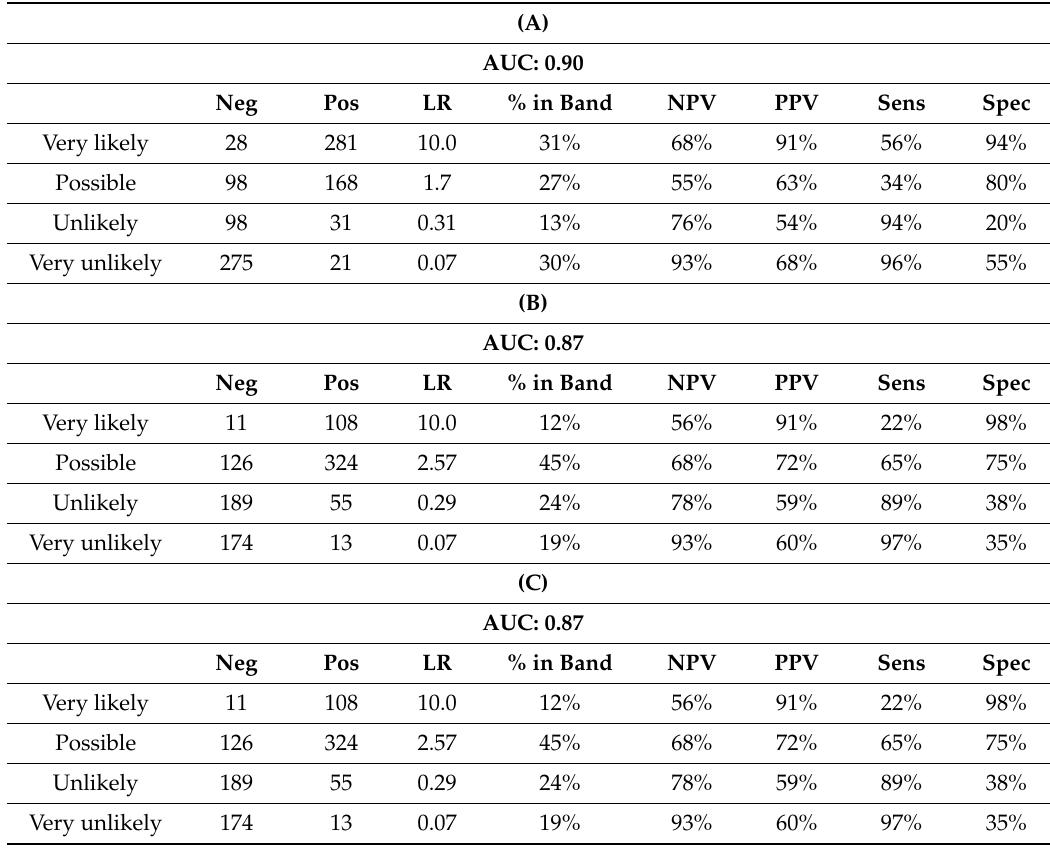
Table 4. Impact of varying AUCs on test characteristics using modelled data. Shown are estimated performance at AUCs of ( A ) 0.9, ( B ) 0.87, and ( C ) 0.85 at a prevalence of 50%. Here, we had LRs fixed at 0.075 for the very unlikely band and at ~10 (or as close as possible) for the very likely